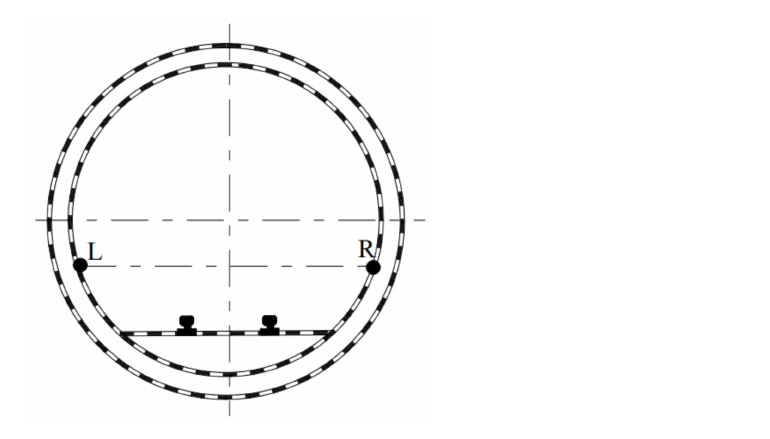
Figure 10. Schematic diagram of the measuring points in the tunnel.